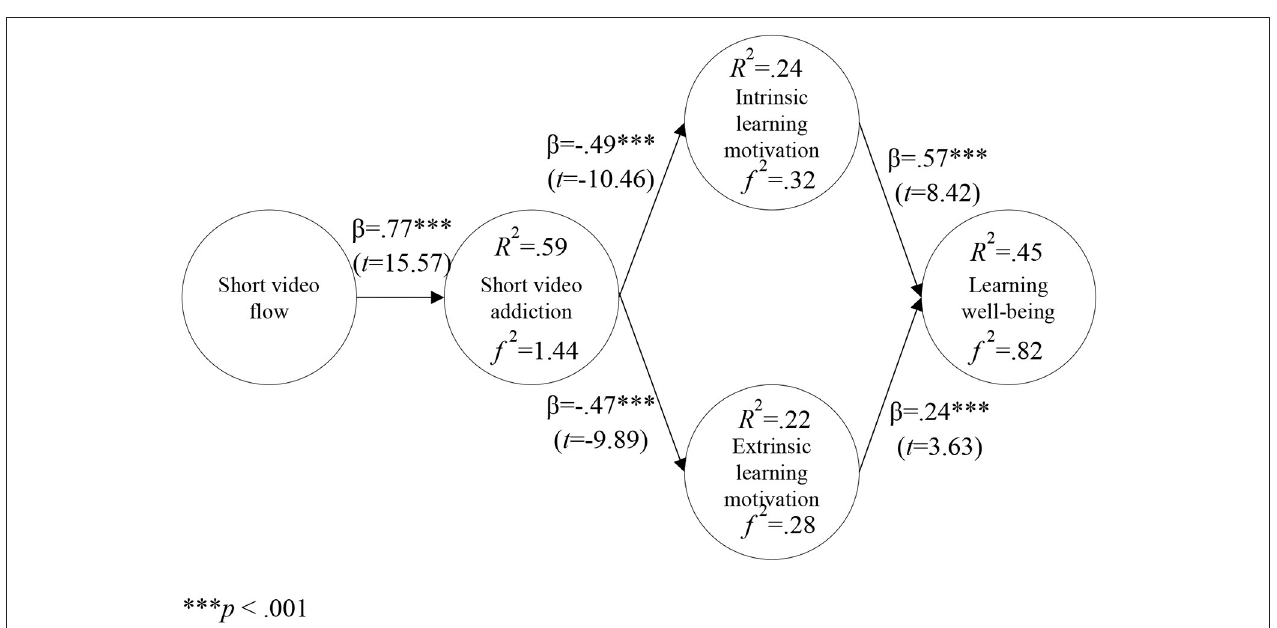
FIGURE 2 | Model Verification. *** p <